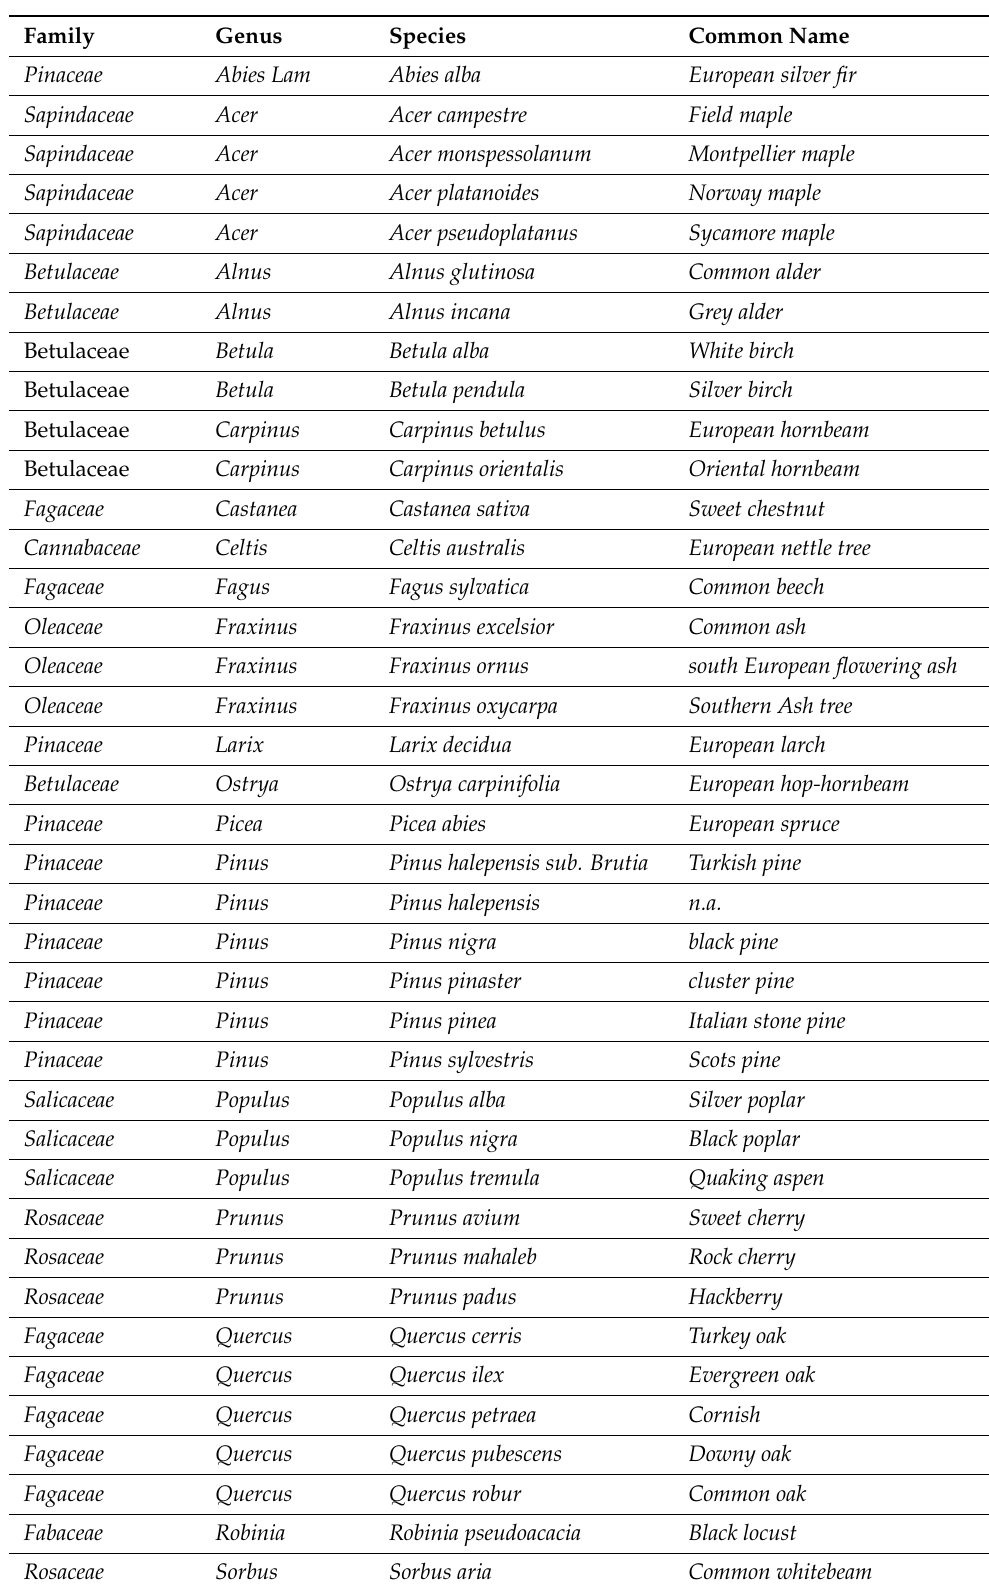
Table A1. Vegetation Database: Tree Species Dominating Forests in the FVG Region: Family, Genus, Species and Common